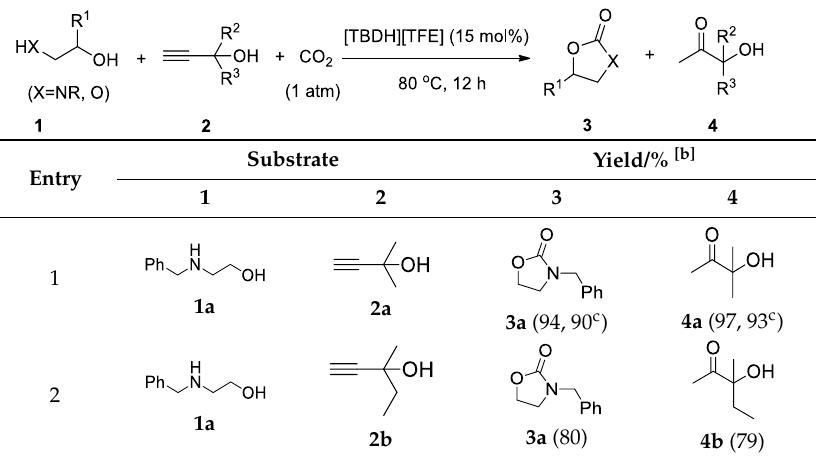
Table 3. Scope of the substrates for the reaction under optimized conditions [a] .